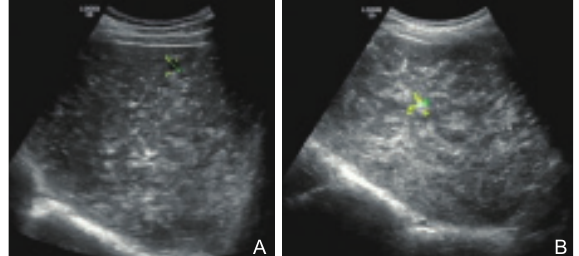
Figure 1 2-D ultrasound scan showed multiple cystic echoes with a maximum diameter of 9 mm (A) and hyperechoic lesions with a maximum size of 10 × 9 mm(B) throughout the liver.